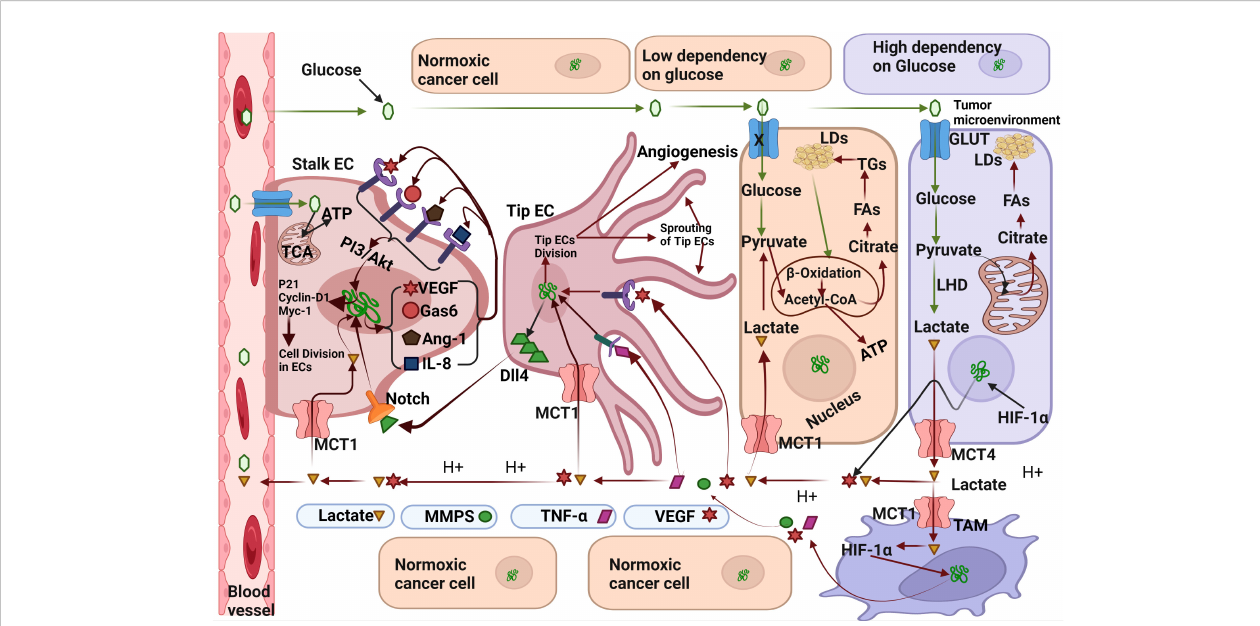
FIGURE 1 Molecular mechanism exploited by Lactate for angiogenesis induction. Hypoxic cancer cells can metabolise glucose only by glycolysis resulting in accumulation of lactate which is secreted in the tumor microenvironment (TME) through the monocarboxylate transporter-1(MCT-4). Lactate from TME fl ows towards nearby blood vessels and enters endothelial cells (EC) through MCT-1 transporter. After entering stalk epithelial cells, lactate upregulates the expression various pro-angiogenic genes like-Gas6, VEGF, Ang-1, and IL-8 which acts in the autocrine mechanism on their respective receptors. Gas-6 binds to the Tie2 receptor, VEGF binds to the VEFR2 receptor, Ang-1 binds to the Axl receptor, and IL-8 binds to the IL-8 receptor. Activation of VEGFR2, Tie2, IL-8 and Ang-1 receptors initiate cell division in stalk epithelial cells by activation of Cyclin-D/Myc-1/p21 genes and subsequently lead to the differentiation of stalk epithelial cells into new blood vessels. Fatty acids synthesised from lactate derived citrate in normoxic cancer cells transported towards the stalk ECs wherein used in b -Oxidation to full fi ll their energy needs. Lactate also enters tip epithelial cells and activates various genes which also regulate the cells division of tip ECs. A fraction of lactate also enters the tumor associated macrophages (TAM) through MCT-1 transporter and activates the in fl ammatory mediators like TNF- a , Vascular Endothelial Growth Factor and Metalloproteinases (MMPs). MMPs digest the stromal proteins, clears the road to sprouting blood vessels. Binding of VEGF and TNF- a also upregulates the expression of Delta-like-ligand 4(Dll4) which further regulate the differentiation of adjacent stalk ECs via NOTCH signalling pathway. Created by